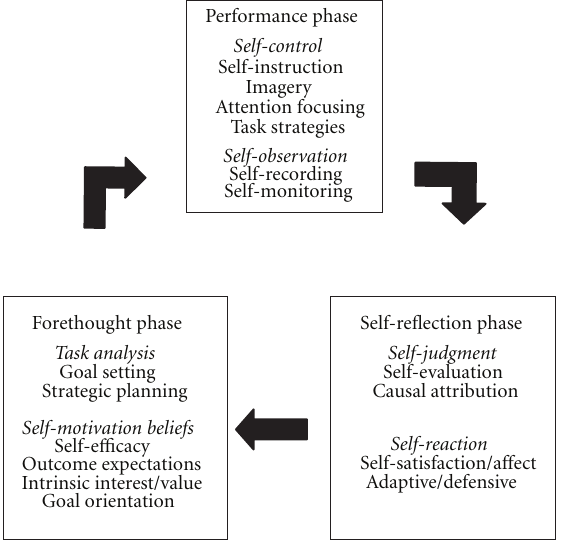
Figure 1: Phases and subprocesses of self-regulation. From [32] Copyright (2003) by Cambridge University Press. Reprinted with